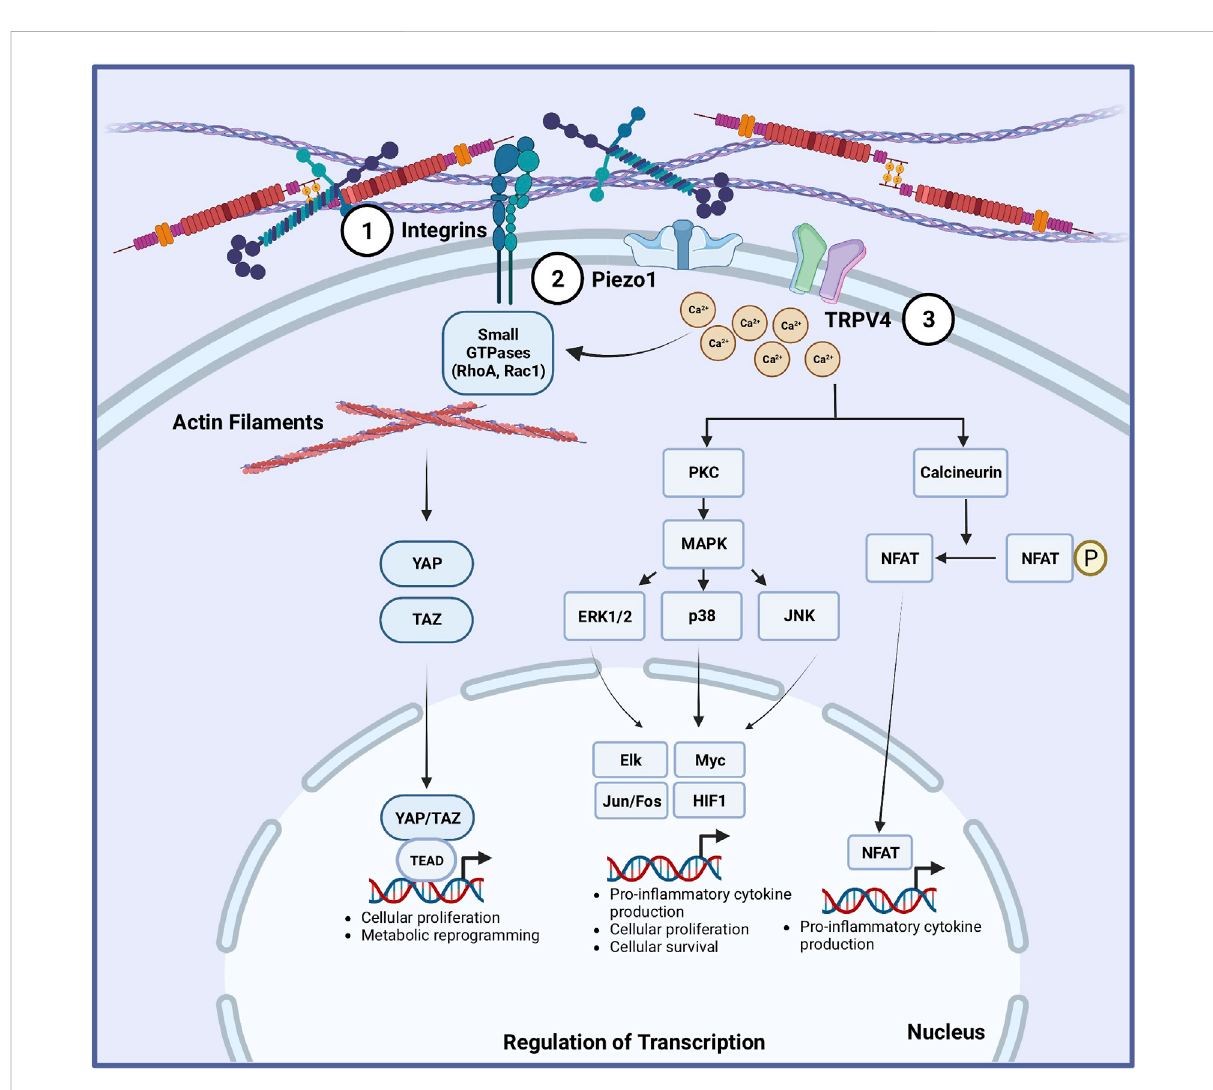
FIGURE 1 Proposed mechanotransduction pathways in macrophages and dendritic cells. Multiple mechanisms are implicated to translate mechanical cuesintocellularresponsesinmacrophagesanddendriticcells(DCs)(Martino etal.,2018).Integrinscansenseextracellularmatrixstiffnesschanges, which can translate into activation of small GTPases and subsequent modi fi cation of the subcellular organization and structure of F-actin fi laments. This is linked to activation of the Hippo signaling pathway by increasing YAP/TAZ activation, leading to the upregulation of genes involved in glycolysis, amino acid metabolism, cellular proliferation and cell survival. Mechanosensitive ion channels are expressed in macrophages and DCs, including Piezo1 (Shaheen et al., 2017) in both, and TRPV4 (Oakes et al., 2009) in macrophages. Physical forces change the tension in the plasma membraneofcells,causingtheionchannelstoopen.Piezo1andTRPV4openingallowstheentryofextracellularCa 2+ ionsintothecells.Thein fl uxof Ca 2+ ions can activate the protein kinase C (PKC)/mitogen-activated protein kinase (MAPK) pathway or calcineurin/NF- κ b pathway, leading to